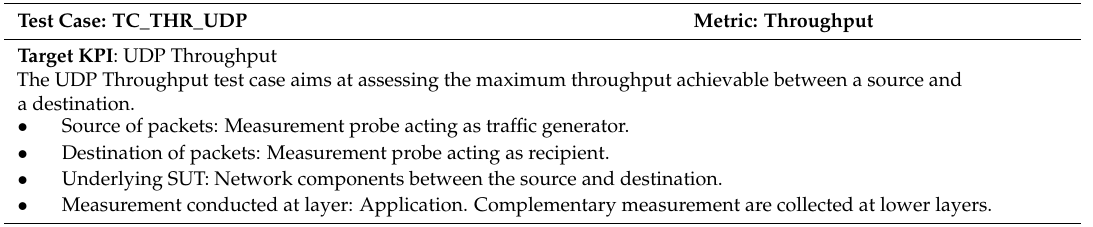
Table 2. Test case for assessing the maximum throughput available at the application